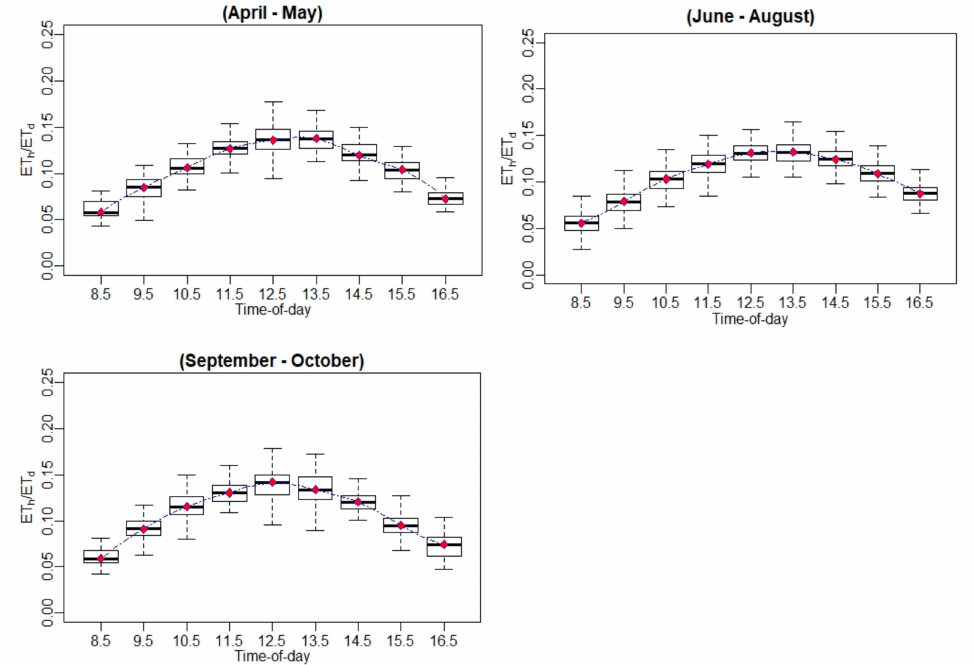
Figure A21. Hourly ET -to-daily ET ratio ( ET h /ET d ) variation using EC measurements.